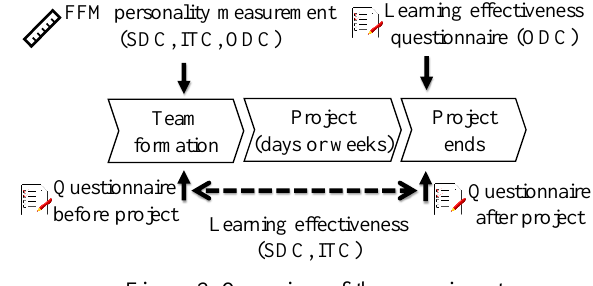
Figure 2. Overview of the experiment Table 2. Features of each